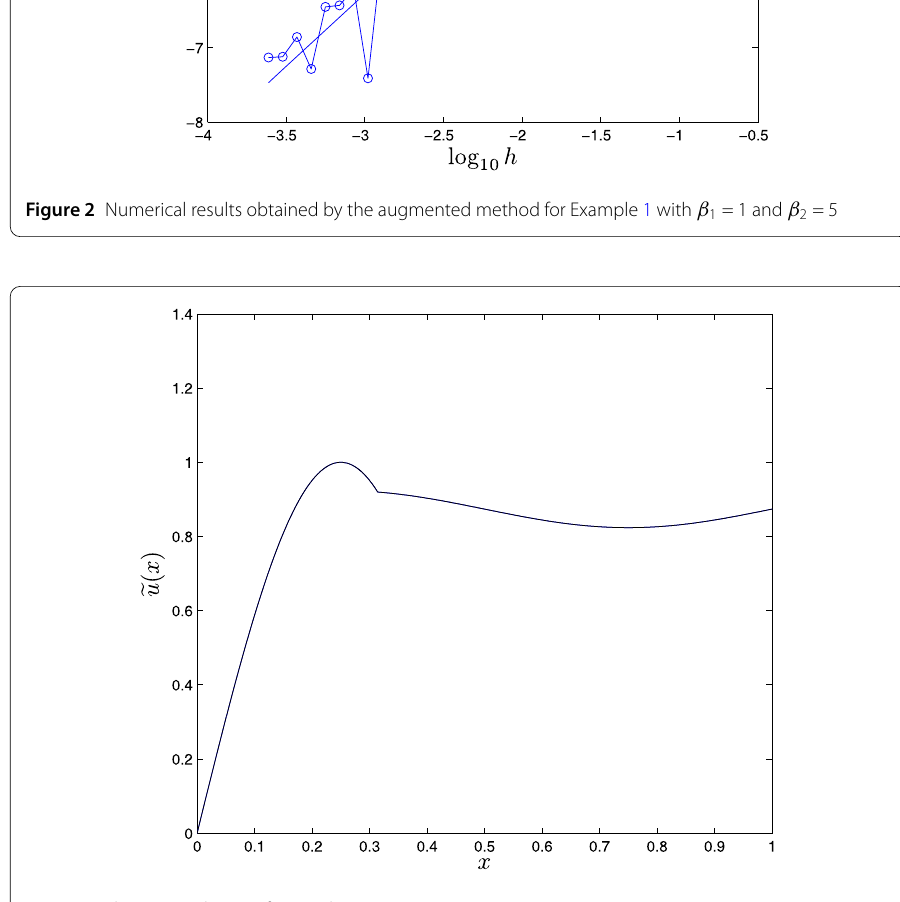
Figure 3 The exact solution of Example 2